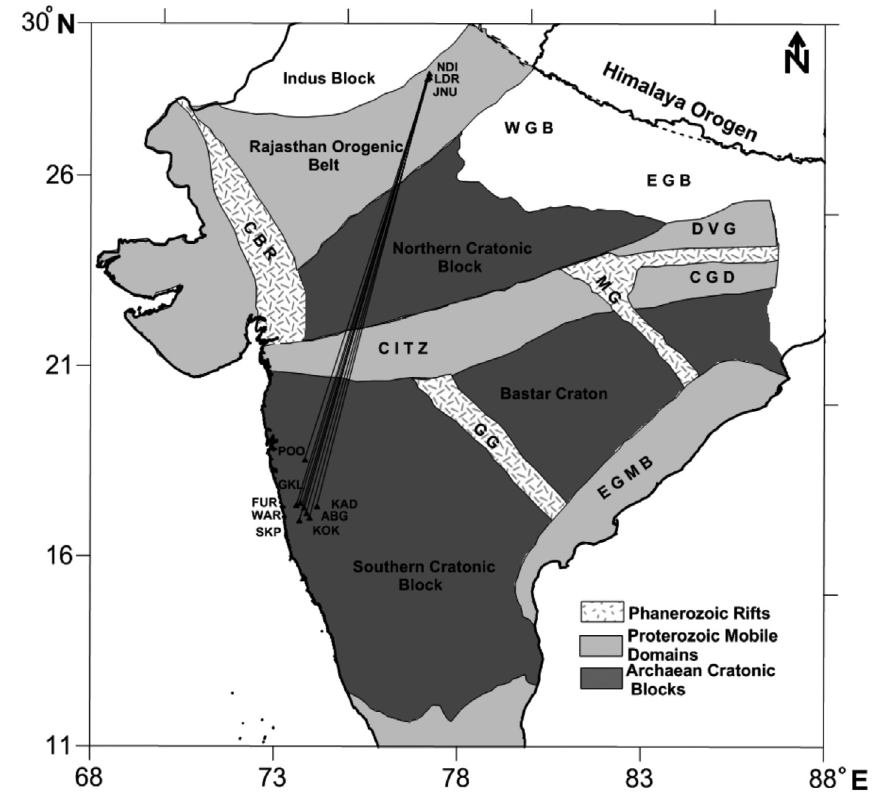
Figure 1. Precambrian cratonic blocks and associated mobile belts in and adjoining regions of present study (figure modified from Ma- hadevan [2013]). Abbreviations: CBR, Cambay rift; CITZ, Central Indian Tectonic Zone; DVG, Damodar Valley Graben; CGD, Chotanag- pur Gneissic-Granitic Domain; EGMG, Eastern Ghat Mobile Belt; GG, Godavari Graben; WGB, West Ganga Basin; EGB, East Ganga Basin. Locations of observatories (triangles) and the inter-station wave paths used in this study are